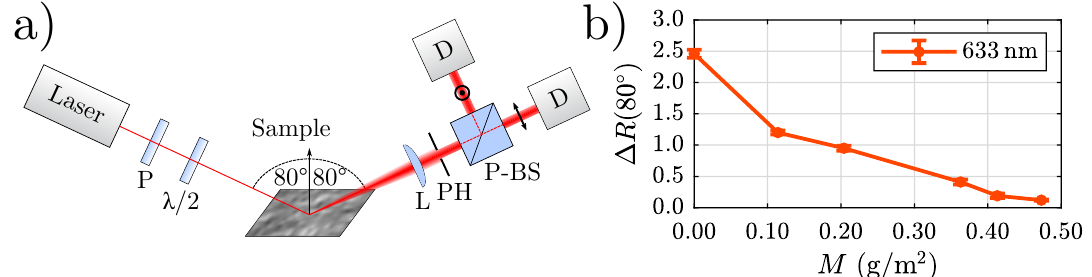
Figure 1. ( a ) Sensor concept for investigating the trivalent chromium conversion (TCC) coatings using θ in = θ out = 80 ◦ and a polarization direction of 45 ◦ (P: polarizer; λ /2: waveplate; L: lens, f =